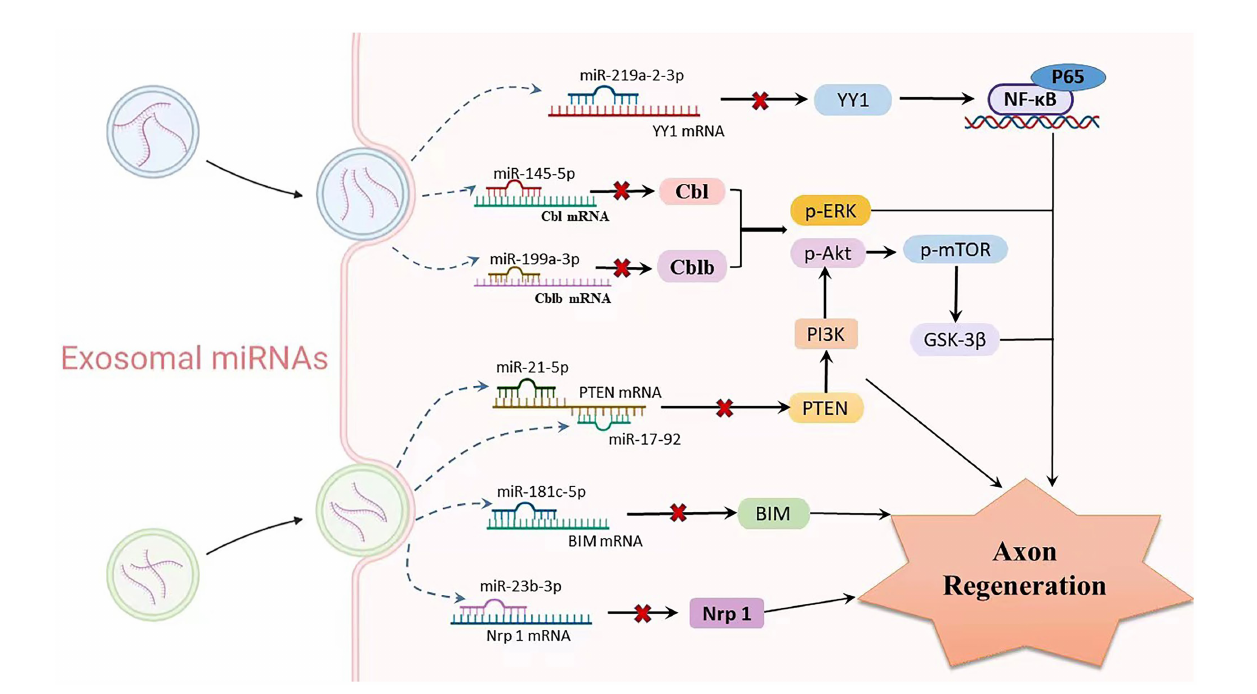
FIGURE 4 Relationship between exosomal miRNAs and axon regeneration. As one of the important cargos of exosomes, miRNAs are involved in mediating the process of axon regeneration. Exosomes produced by various stem cells enter neurons or glial cells through paracrine routes, where multiple miRNAs are released. Upregulation of exo-miR-219a-2-3p inhibits YY1 expression, thereby suppressing the NF- κ B-p65 pathway and exerting neuroprotective effects. miR-199a-3p/145-5p suppresses Cblb and Cbl expression and causes upregulation of p-Erk and p-Akt, subsequently promoting neurite outgrowth. The miR-17-92 cluster and miR-21-5p carrying exosomes downregulate PTEN levels and subsequently activate the PI3K/Akt/mTOR signalling pathway, thereby increasing neuronal dendritic plasticity. MiR-181c-5p negatively regulates BIM mRNA, inhibits BIM expression level, reduces neuronal apoptosis, and promotes axon regeneration. Targeted inhibition of Nrf1 mRNA levels by miR-23b-39 subsequently promotes axonal